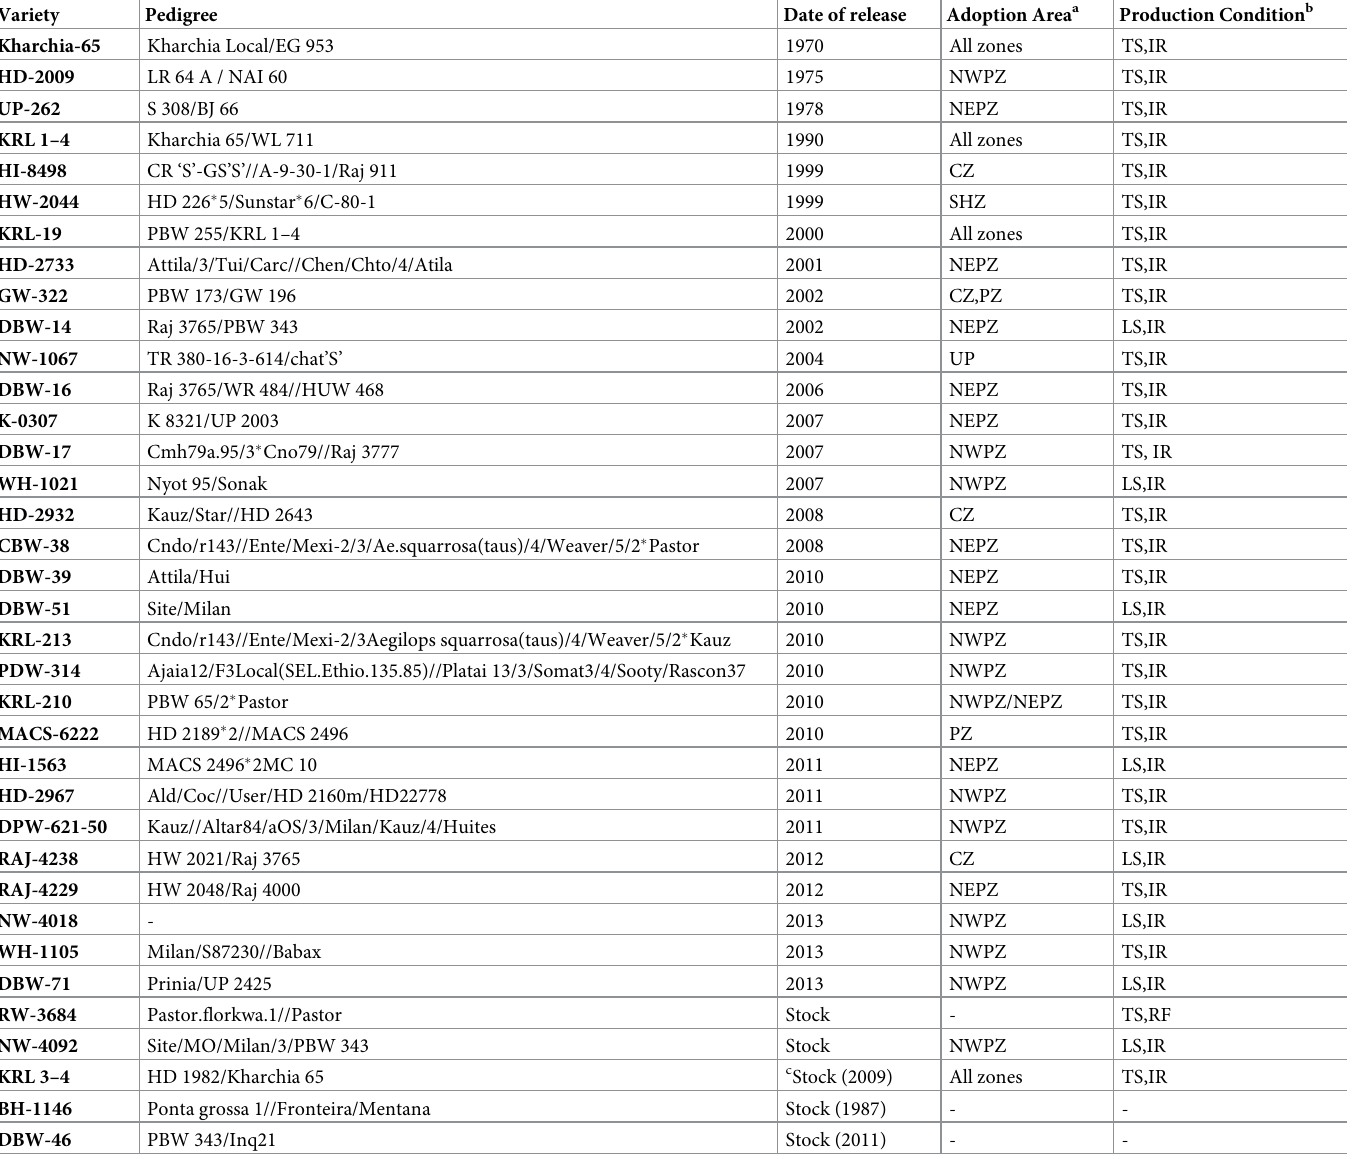
Table 2. Wheat genotypes used in field trials during 2013/14 and 2014/15.